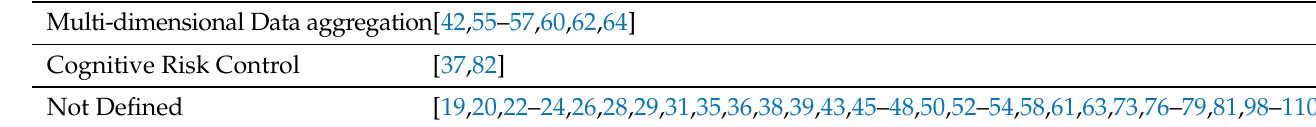
Table 3. Articles that can be classified by means of their Encryption Algorithms.